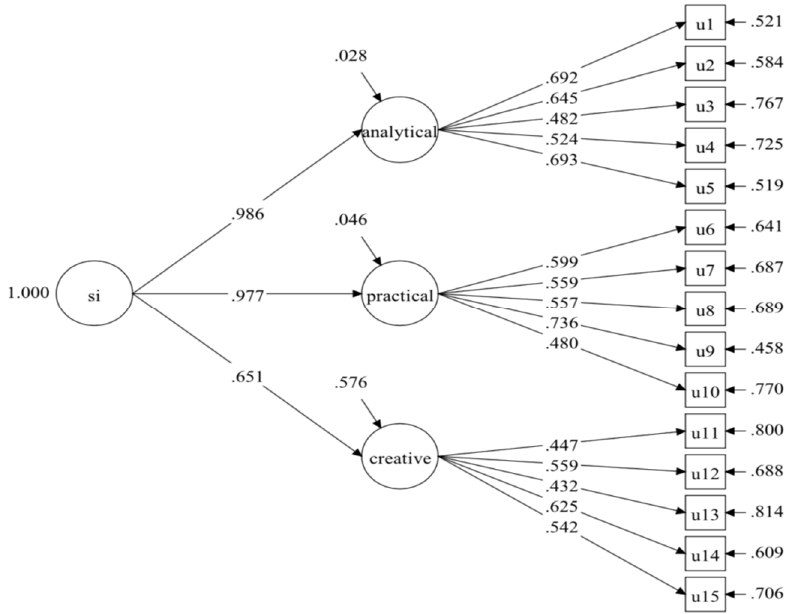
Figure 2. Model 2: one general factor of three abilities. Notes. u1 = Story Problems, u2 = Floating Boats, u3 = Metaphors, u4 = Number Cards (Letter Math), u5 = Words That Sound the Same (Homophones), u6 = Paper Cutting, u7 = Decisions, u8 = Maps, u9 = Exchange, u10 = Toy Shadows, u11 = Interesting (Figurative) Language, u12 = Conversations, u13 = Number Talk, u14 = Multiple Uses, u15 = Book Covers.